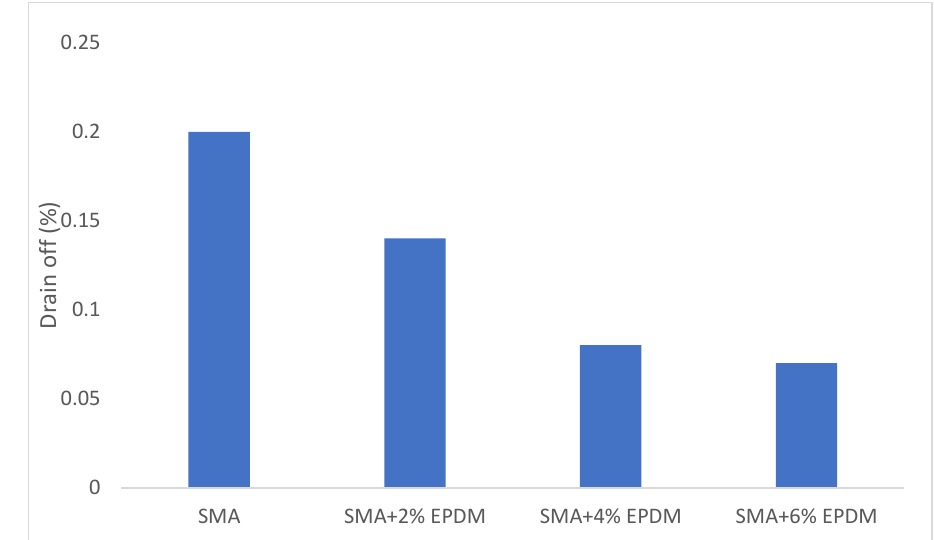
Figure 11. Drain-off test results.